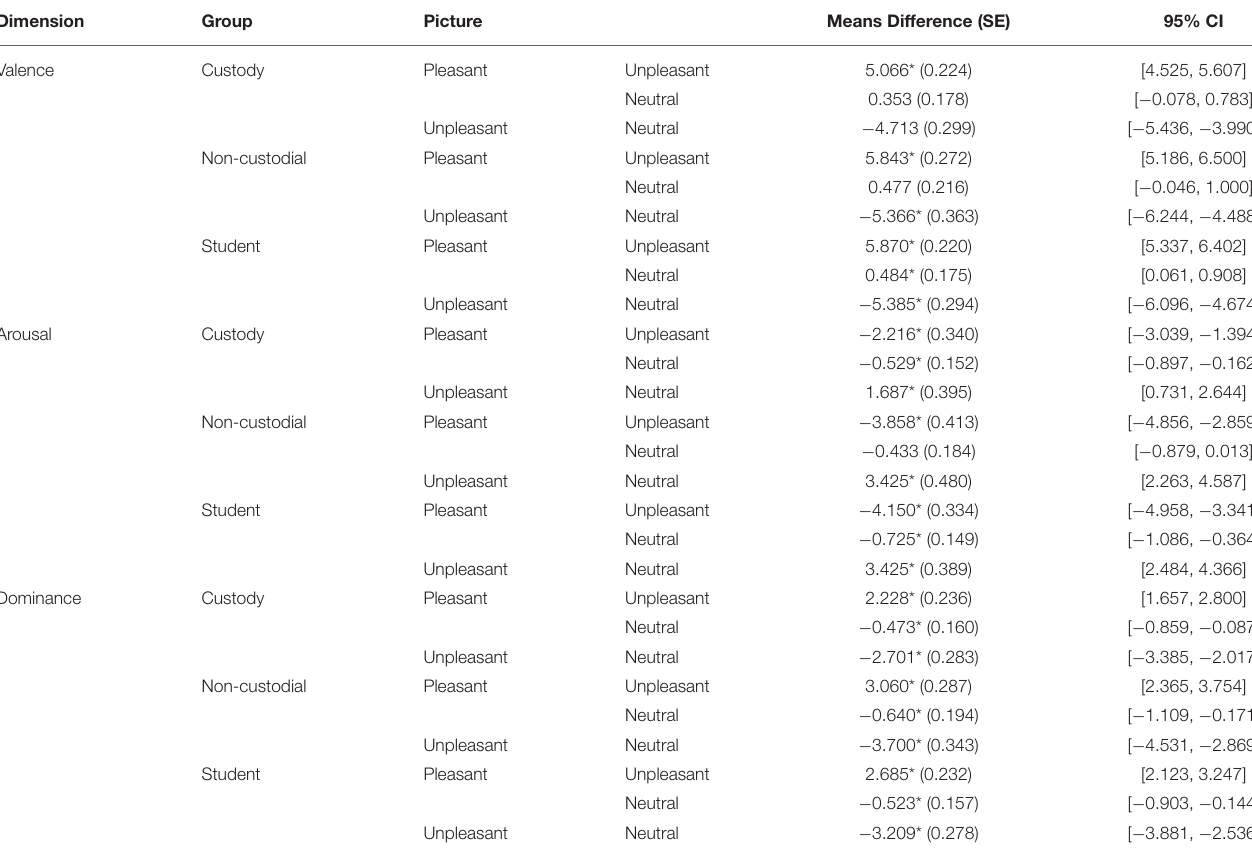
TABLE 1 | Post-hoc pairwise comparison according to type of picture. Dimension